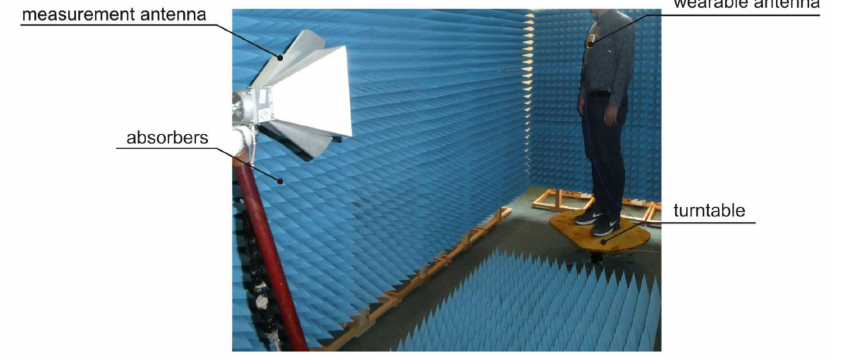
Figure 22. The measurement setup for measurement of wearable antenna radiation